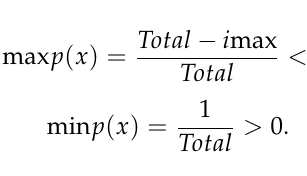
Figure 5. The update flowchart for histogram with fast adaptation. The maximum probability max ( ) p x and the minimum probability min ( ) p x can be